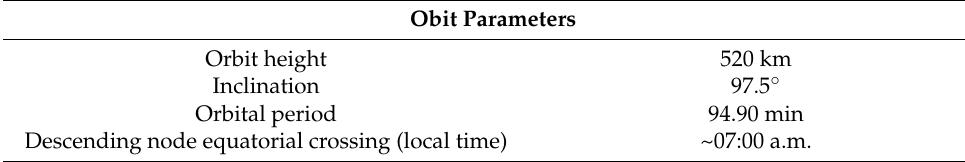
Table 2. List of the main specifications of CSAT.